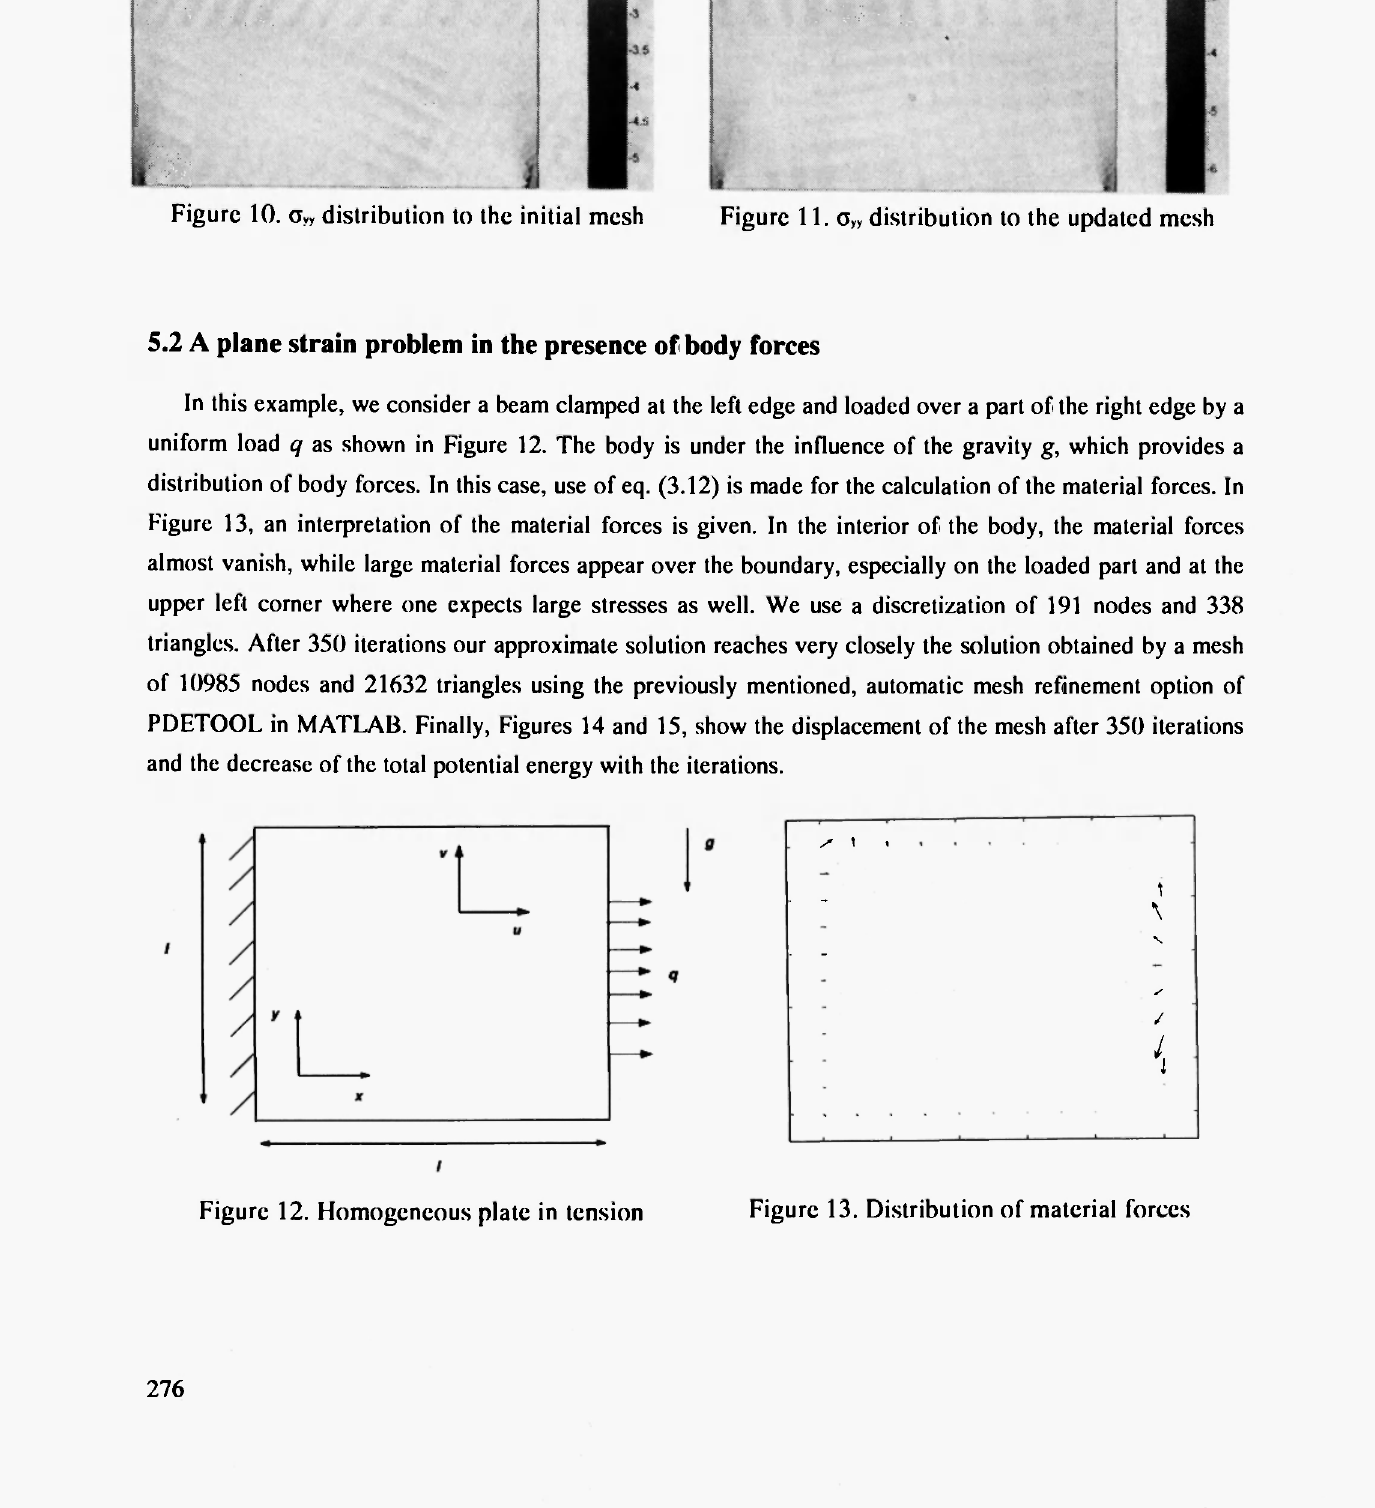
Figure 10. σ„ distribution to the initial mesh Figure 11. o„ distribution to the updated mesh